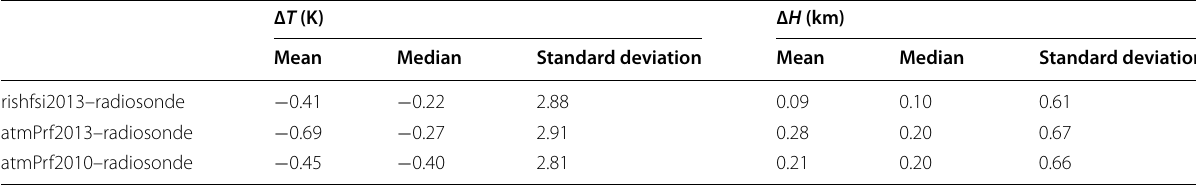
Table 5 Statistical differences of LRT between GPS-RO and a radiosonde ∆ T